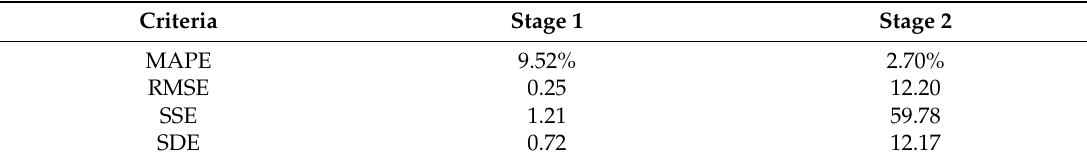
Table 1. Accuracy Analysis of the Proposed Method—Spring Day.